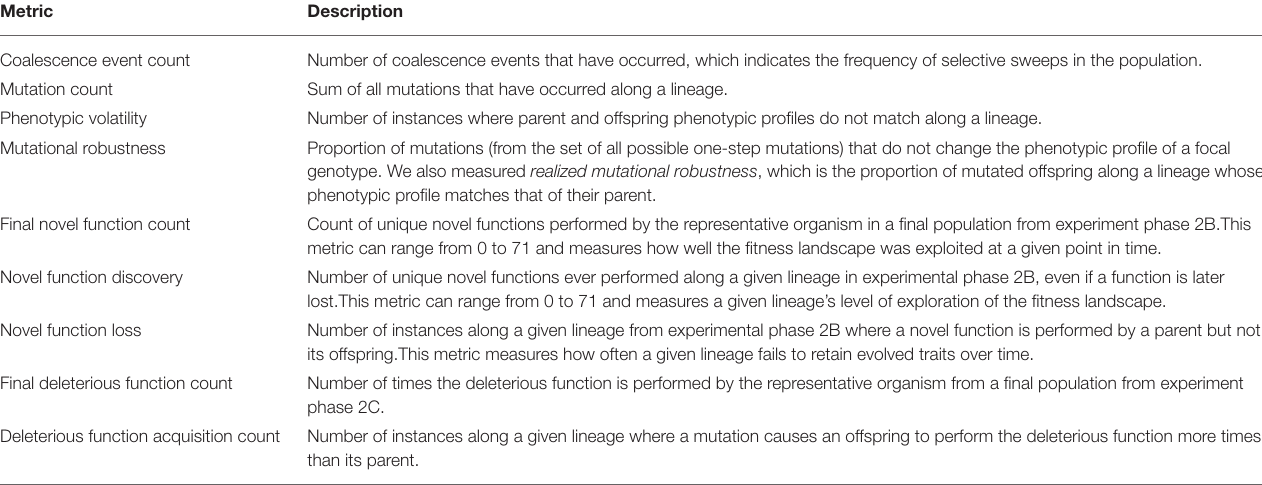
TABLE 1 | Metric descriptions. Metric Description Coalescence event count Number of coalescence events that have occurred, which indicates the frequency of selective sweeps in the population. Mutation count Sum of all mutations that have occurred along a lineage. Phenotypic volatility Number of instances where parent and offspring phenotypic profiles do not match along a lineage. Mutational robustness Proportion of mutations (from the set of all possible one-step mutations) that do not change the phenotypic profile of a focal genotype. We also measured realized mutational robustness , which is the proportion of mutated offspring along a lineage whose phenotypic profile matches that of their parent.